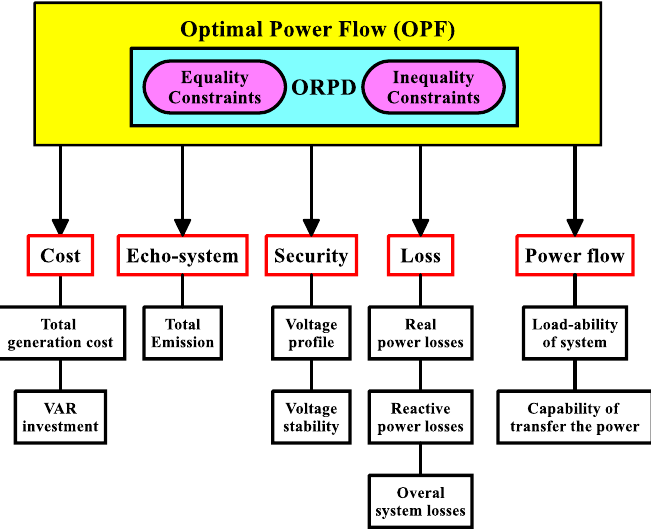
Figure 3. Overview of important objective functions in both OPF and ORPD problems.